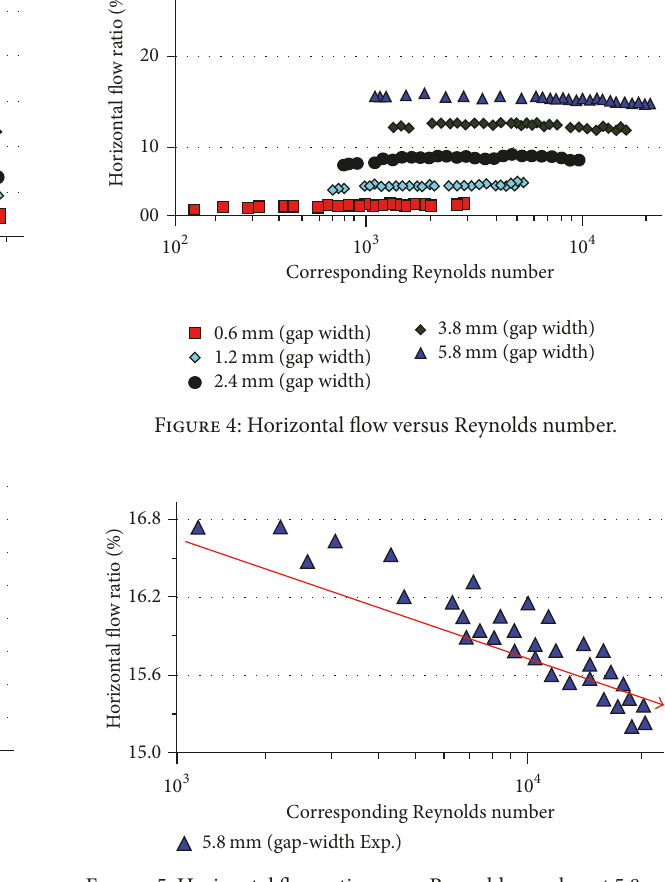
Figure 5: Horizontal flow ratio versus Reynolds number at 5.8